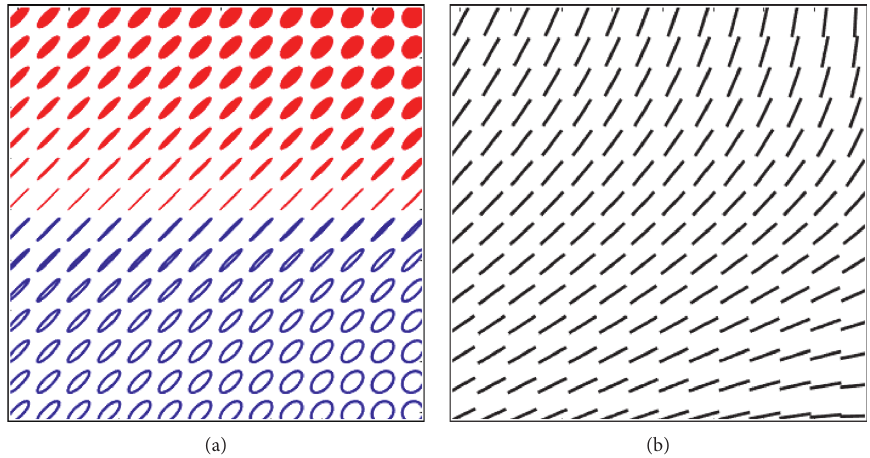
Figure 3: Inhomogeneous polarization distributions: (a) an ellipse field distribution; (b) a vector field